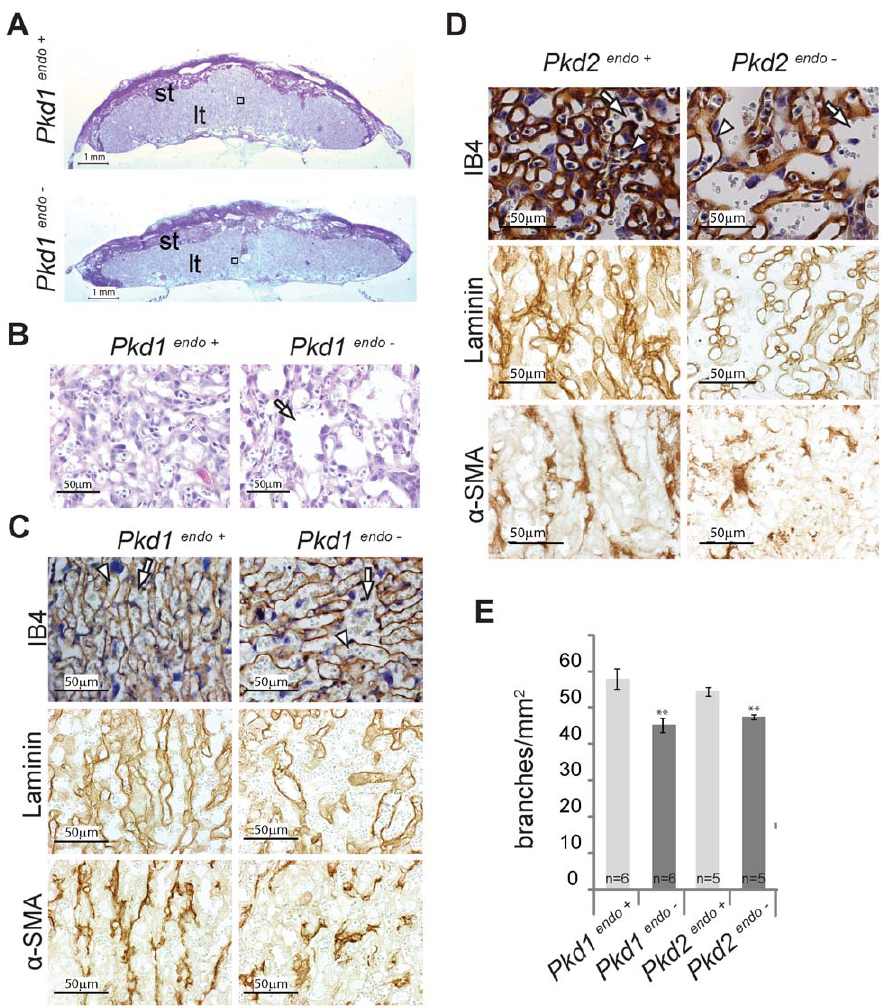
Figure 5. Deletion of Pkd1 or Pkd2 in endothelial cells results in abnormal placental histology. A, B. Representative E14.5 Pkd2 endo 2 and littermate control ( Pkd2 endo + ) placental sections stained with PAS. Area within the square of Panel A is located in the labyrinth layer (lt), and is shown at larger magnification in Panel B. ‘‘st’’=spongiotrophoblast. Arrow indicates a dilated vascular space that is likely maternal. C, D. Representative sections of E18.5 Pkd1 endo 2 (Panel C, right), E14.5 Pkd2 endo 2 (Panel D, right) and littermate control placentas ( Pkd1 endo + and Pkd2 endo + left panels, C and D, respectively) stained as indicated. Both Pkd1 endo 2 and Pkd2 endo 2 placentas have fewer fetal vessels and investing pericytes when compared with controls. Arrowheads and arrows denote fetal vessels and maternal vascular spaces, respectively. E. Quantification of vessel density in the placental labyrinth. For Pkd1 endo 2 vs. Pkd1 endo + , the number of vessel branches is 45.3 6 2 and 57.9 6 2.9, respectively. For Pkd2 endo 2 vs. Pkd2 endo + the number of branches is 47.5 6 0.7 and 54.5 6 1.1. P **p , .01.